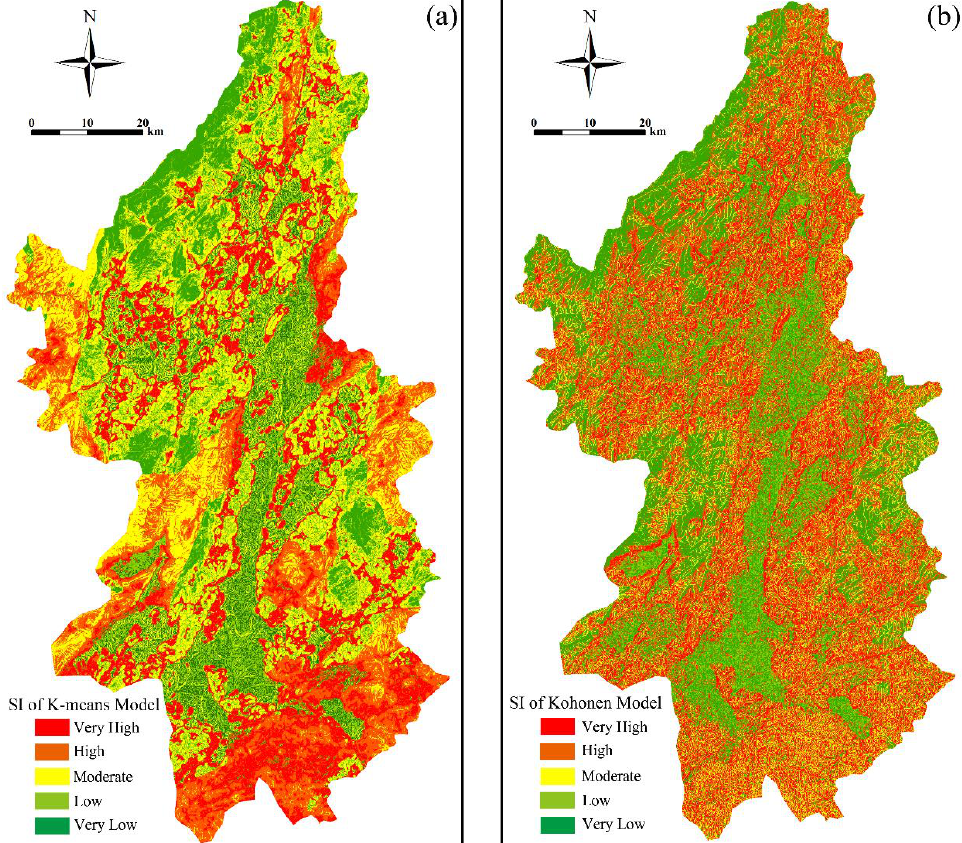
Figure 5. LSMs of the K-means model ( a ) and Kohonen model ( b ).